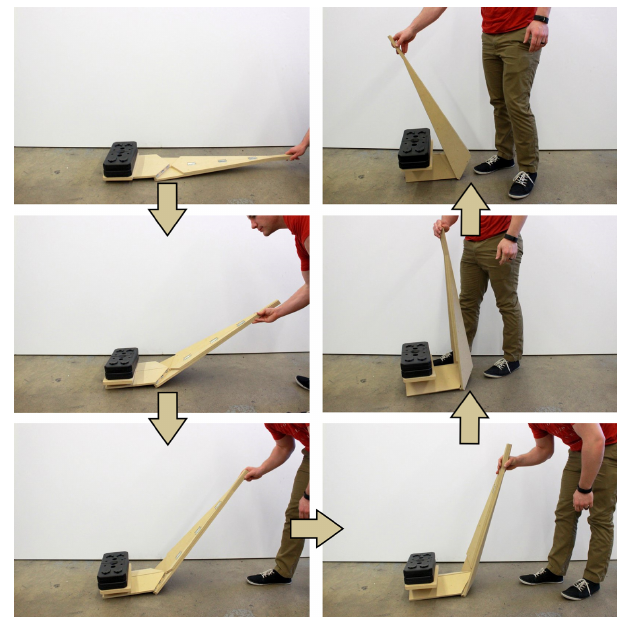
Figure 14. An origami-inspired table is shown through its opening motion.